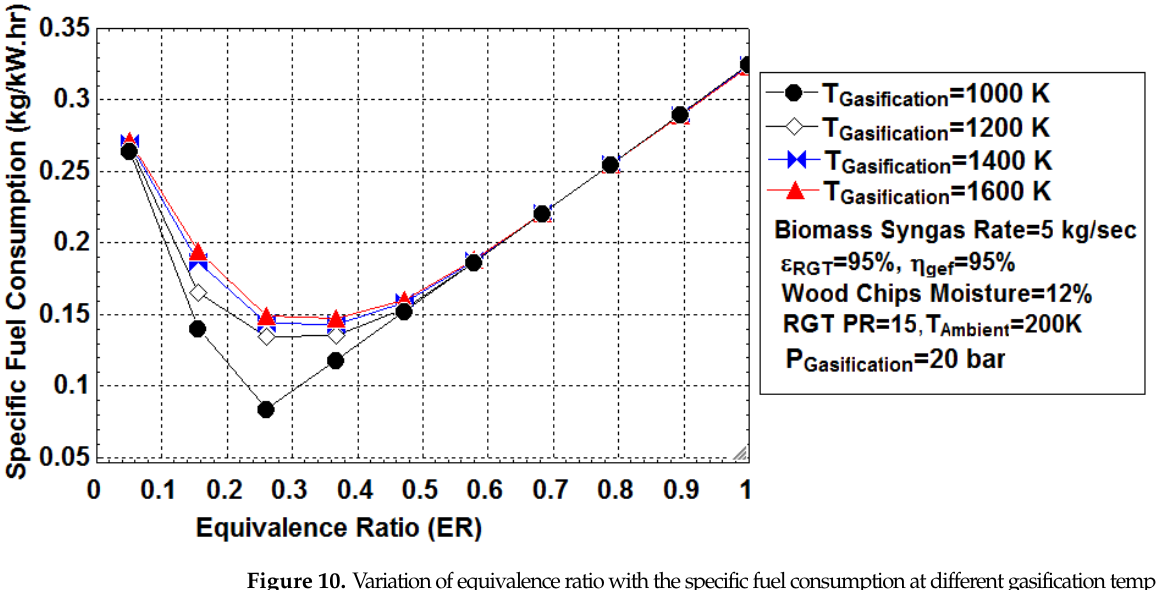
Figure 9. Variation of gasifier efficiency with biomass flow rate at different Wood Chip syngas rates.